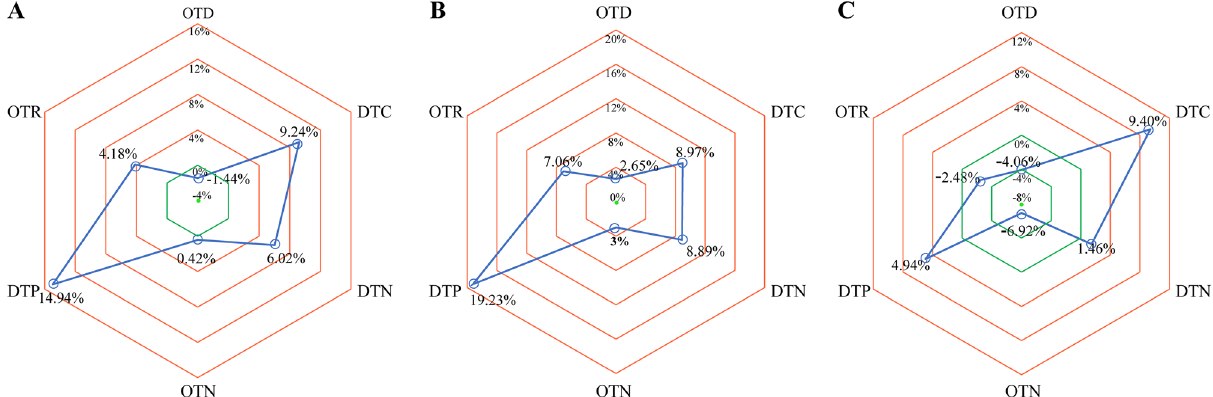
Figure 2. The ratios of changes of mean times from 2019 to 2020. ( A ) The ratios of changes of mean times from 2019 to 2020 in all hospitals. ( B ) The ratios of changes of mean times from 2019 to 2020 in hospitals in the high- risk areas. ( C ) The ratios of changes of mean times from 2019 to 2020 in hospitals in the low/medium-risk areas.